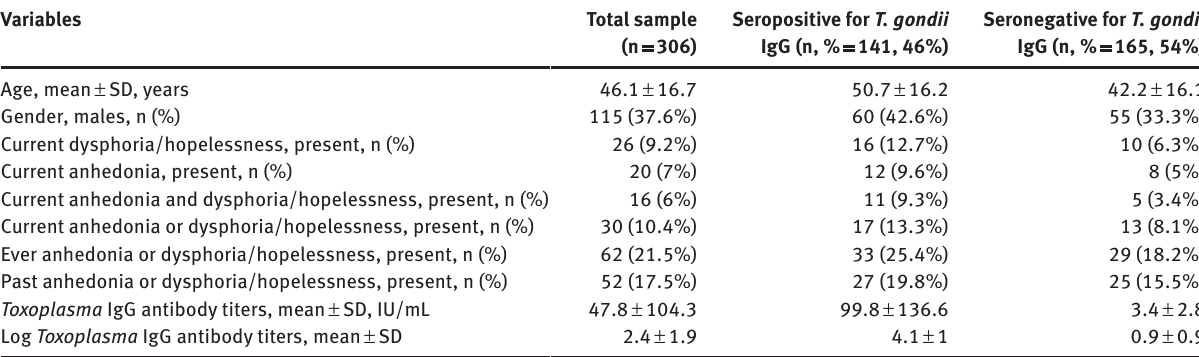
Table 1: Demographic characteristics of the